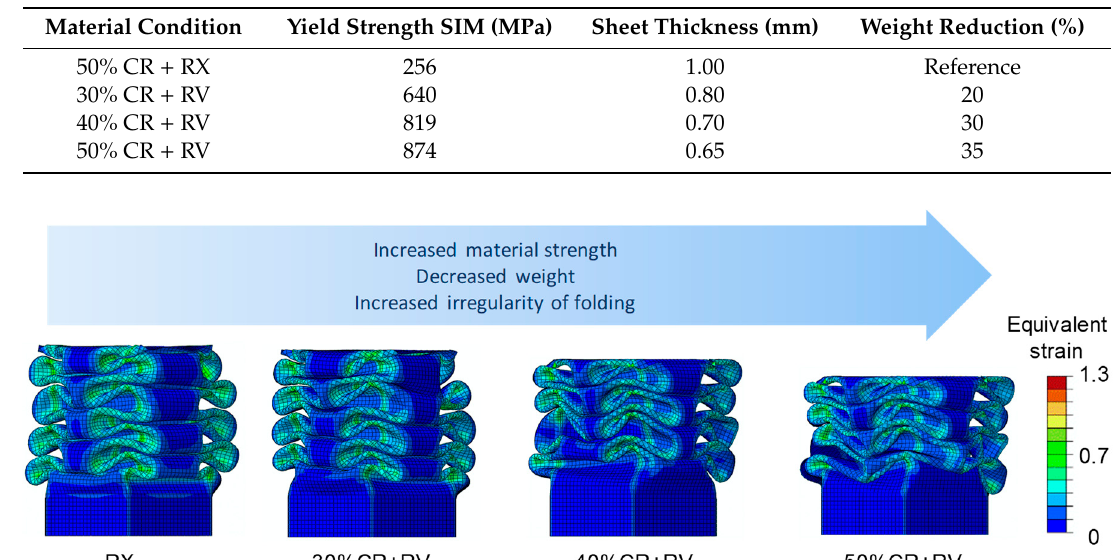
Table 2. Yield strength of simulated flow curves of di ff erent material conditions, individual sheet thickness and weight reduction of di ff erent material conditions.